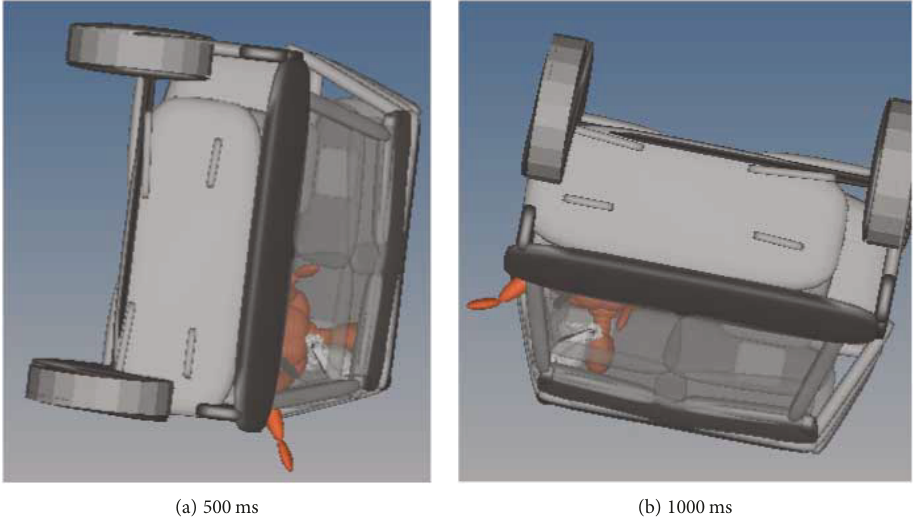
Figure 6: Occupant kinematics with curtain airbag in rollover simulation.